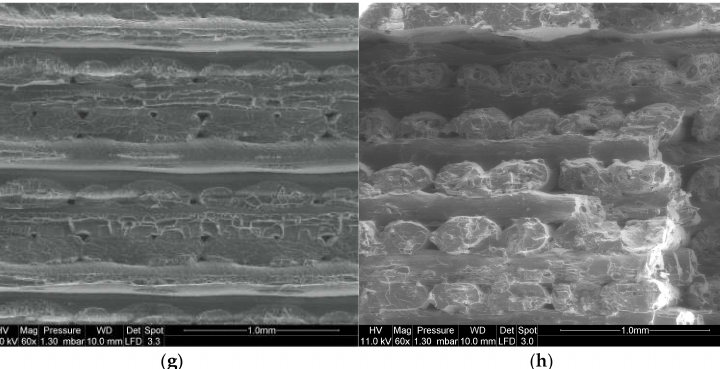
Figure 10. SEM micrographs showing the effect of high printing and bed temperatures on the topography of PLA and PLA-flax fractured surfaces (T P = 210 ◦ C, T B = 60 ◦ C): ( a ) PLA Θ = 0 ◦ ; ( b ) PLA-flax Θ = 0 ◦ ; ( c ) PLA Θ = 15 ◦ ; ( d ) PLA-flax Θ = 15 ◦ ; ( e ) PLA ν = 30 ◦ ; ( f ) PLA-flax Θ = 30 ◦ ; ( g ) PLA Θ = 45 ◦ ; ( h ) PLA-flax Θ = 45 ◦ .